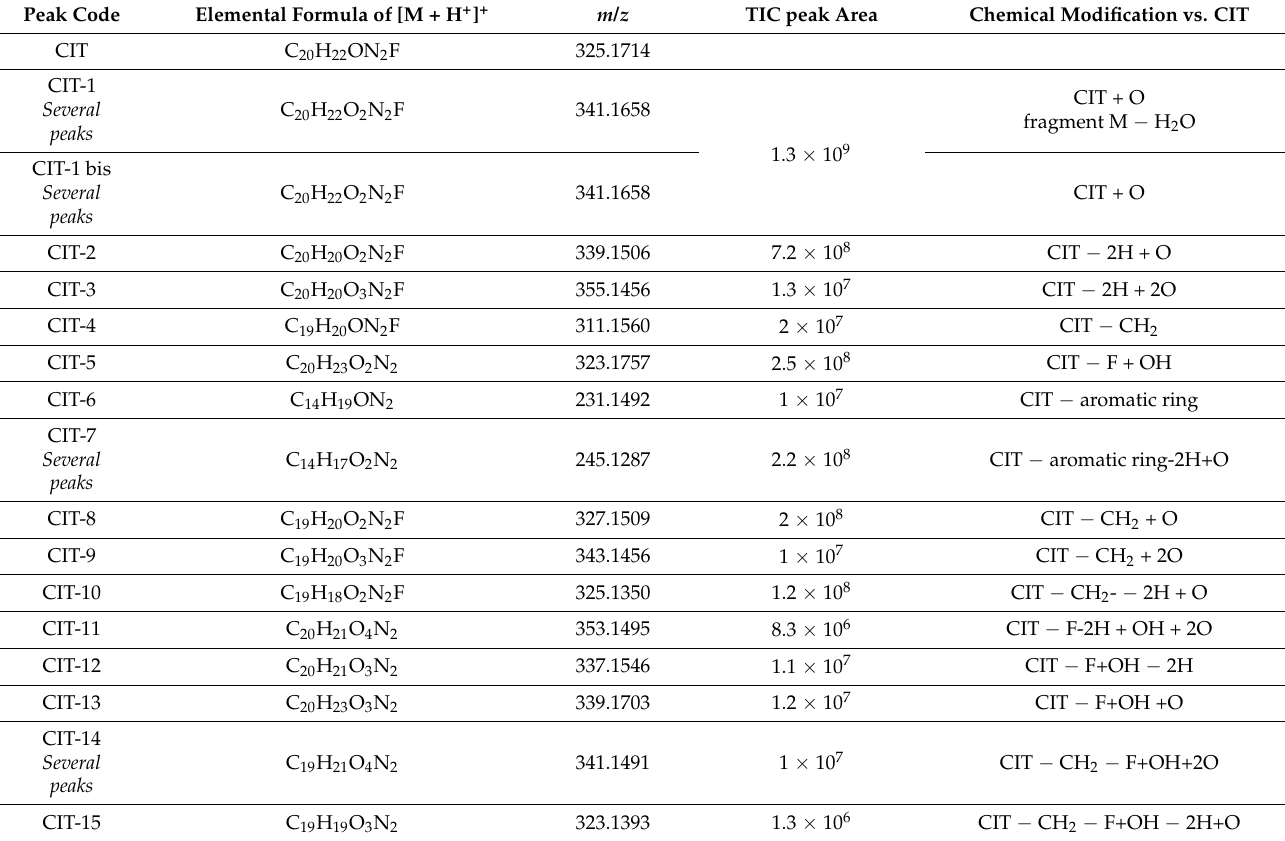
Table 3. HR-MS data of the main photoproducts of CIT after 8 h of irradiation in the presence of WEOM. Percentage of conversion =